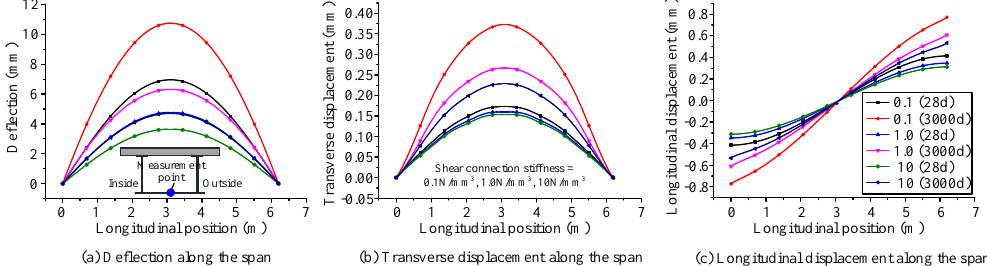
Figure 11. Displacement distribution along the span of curved composite box beam at the initial and ultimate loading ages for different interfacial shear connection stiffness: ( a ) deflection along the span, ( b ) Transverse displacement along the span, ( c ) longitudinal displacement along the span.